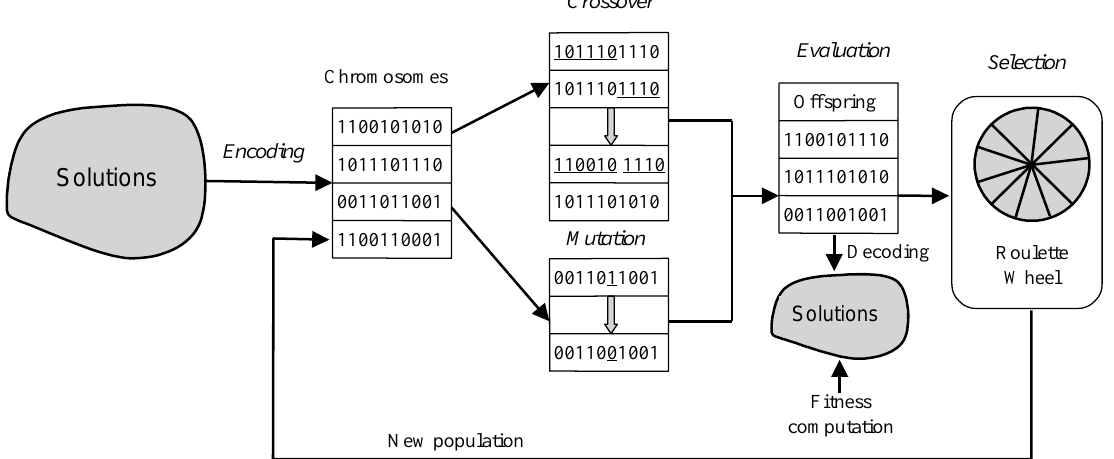
Fig. 4. The general structure of genetic